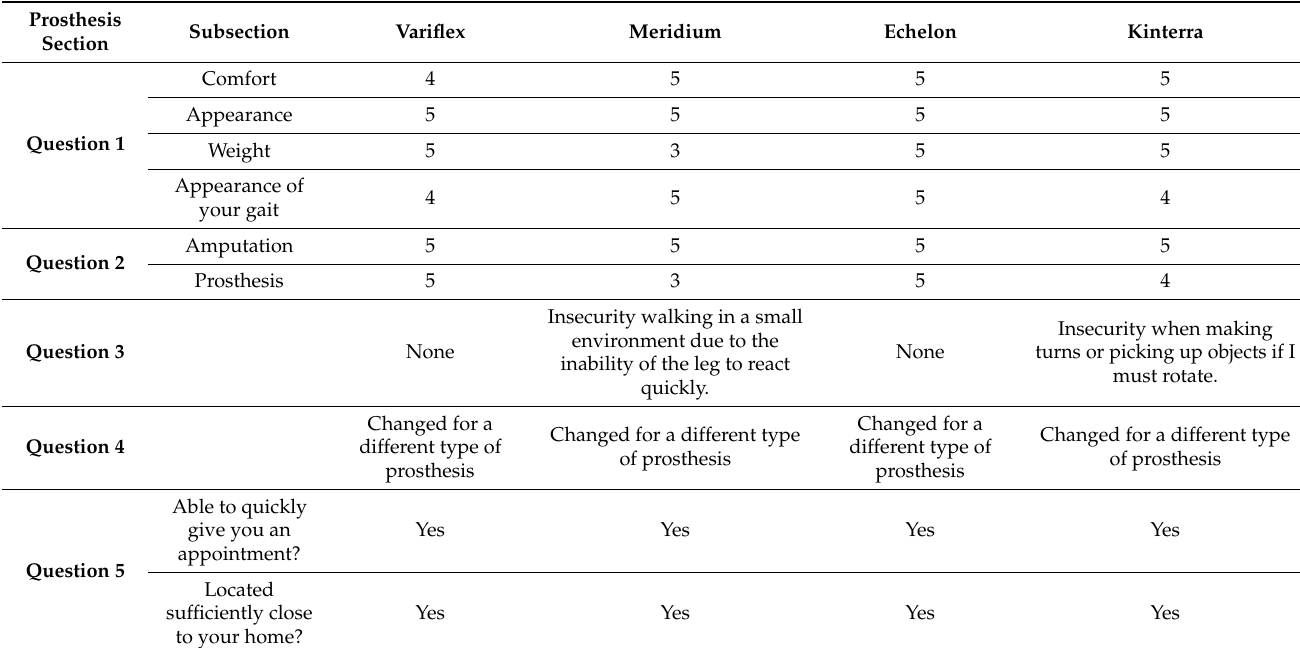
Table 1. The prosthesis section results of the PPA